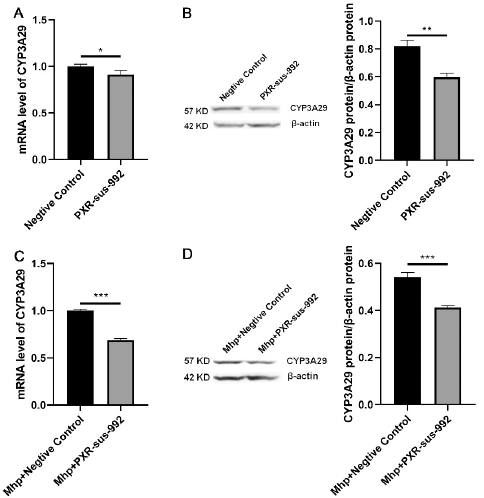
Figure 5. Effect of PXR silencing on CYP3A29 in PAM 3D4/21 cells with or without M. hyopneumoniae infection. ( A ) The mRNA expression level of CYP3A29 after PXR silencing. ( B ) Negative control or PXR -sus-992 were transfected into PAM 3D4/21 cells. The protein expression of CYP3A29 was measured by western blot. ( C ) The mRNA expression level of CYP3A29 after silencing of PXR in PAM 3D4/21 cells infected with M. hyopneumoniae . ( D ) Negative control or PXR -sus-992 was transfected into PAM 3D4/21 cells infected with M. hyopneumoniae . The protein expression of CYP3A29 was measured by western blot. The data are presented as the mean ± SD. The experiment was repeated three independent times. * p < 0.05; ** p < 0.01; *** p < 0.001.